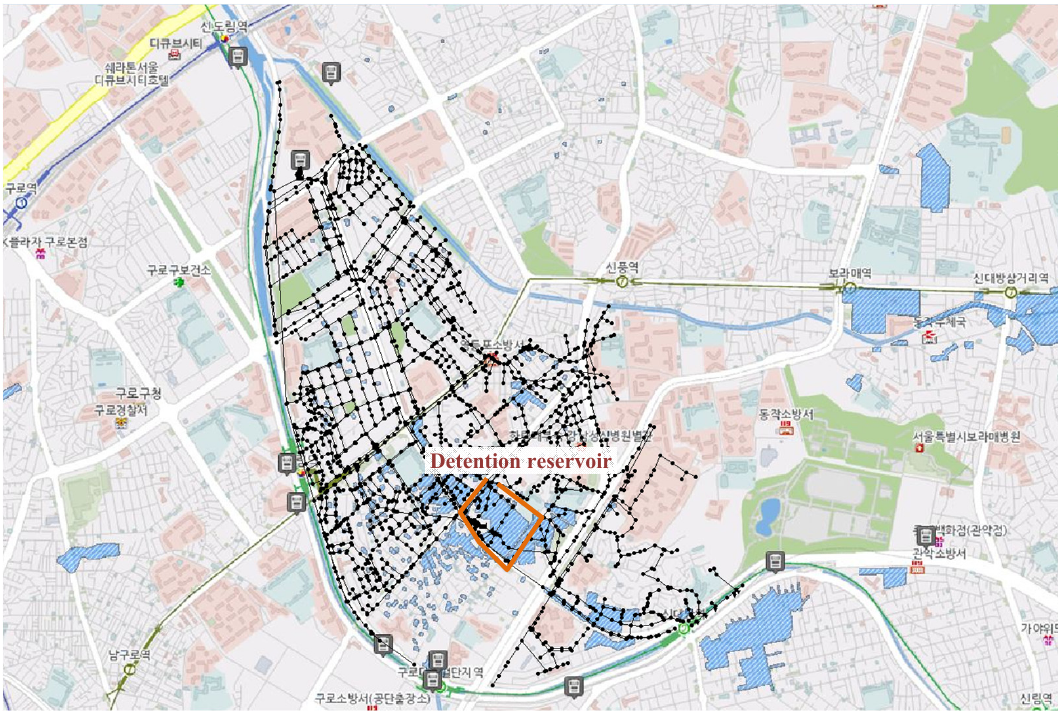
Figure 5. Flooding area (blue hatch pattern) in Daerim3 catchment in September 2010